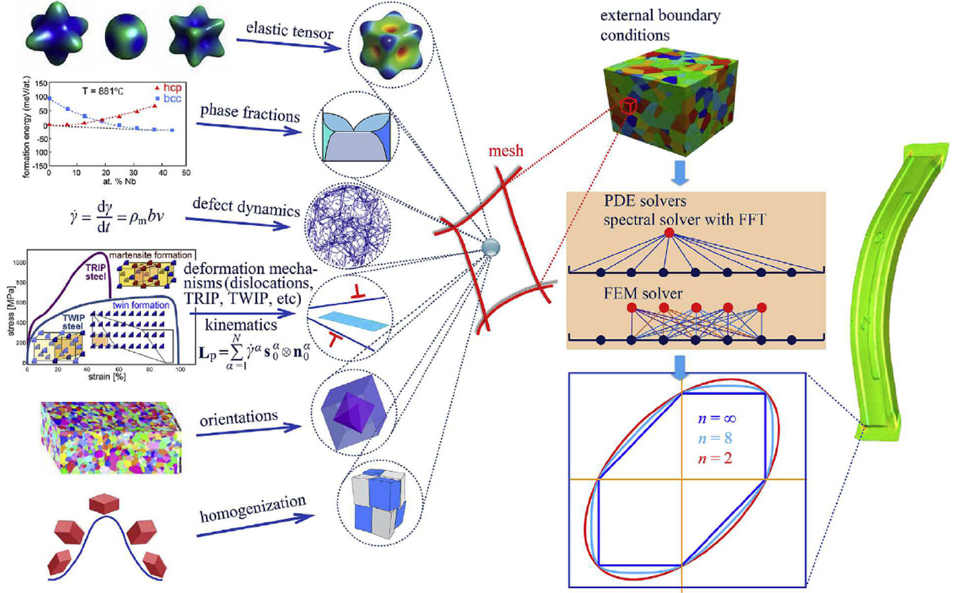
Figure 12. Yield surface calculated by DAMASK, a multi-scale and multi-physics CP modelling framework. Reprinted from Ref. [202] with permission. Copyright 2016, Elsevier.